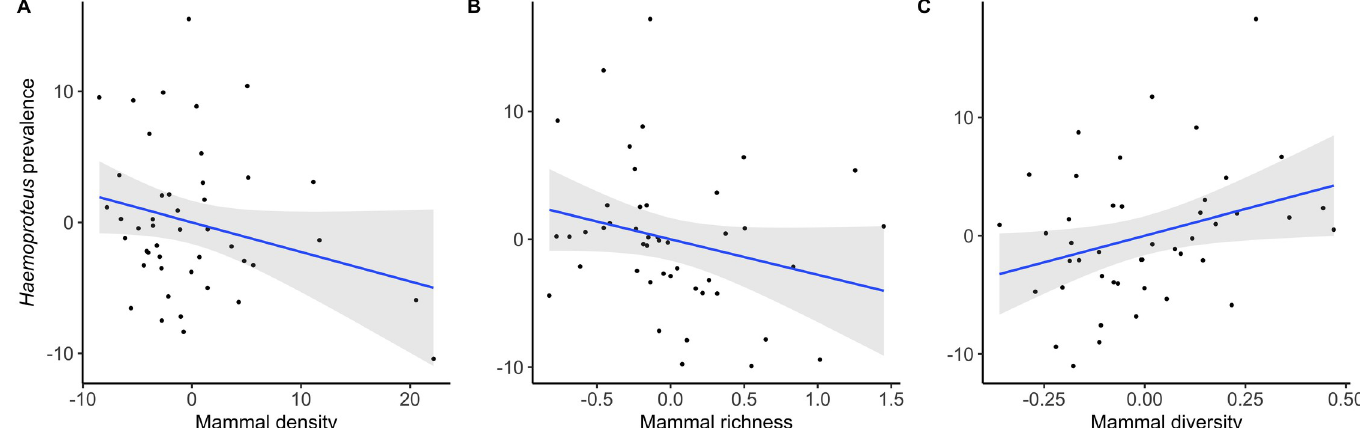
Fig 3. Leverage plots showing the relationships between Haemoproteus prevalence in house sparrows from the 45 localities included in this study and A) mammal density (sum of the density of all mammal species detected at each locality), B) mammal richness (estimated from a rarefaction curve) and C) mammal diversity (measured as the evenness index). The prevalence of Haemoproteus calculated using the least squares means of a GLM controlling for birds’ sex and age, and locality. The 95% confidence level interval is shown in grey.